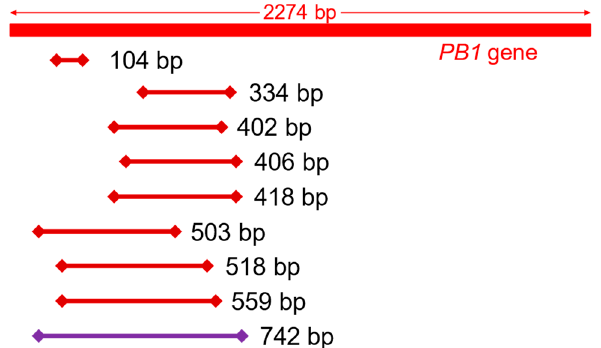
Figure 1. Positions of amplicons on the influenza A virus PB1 gene. The 742 bp amplicon was used as a template for the standard curve.